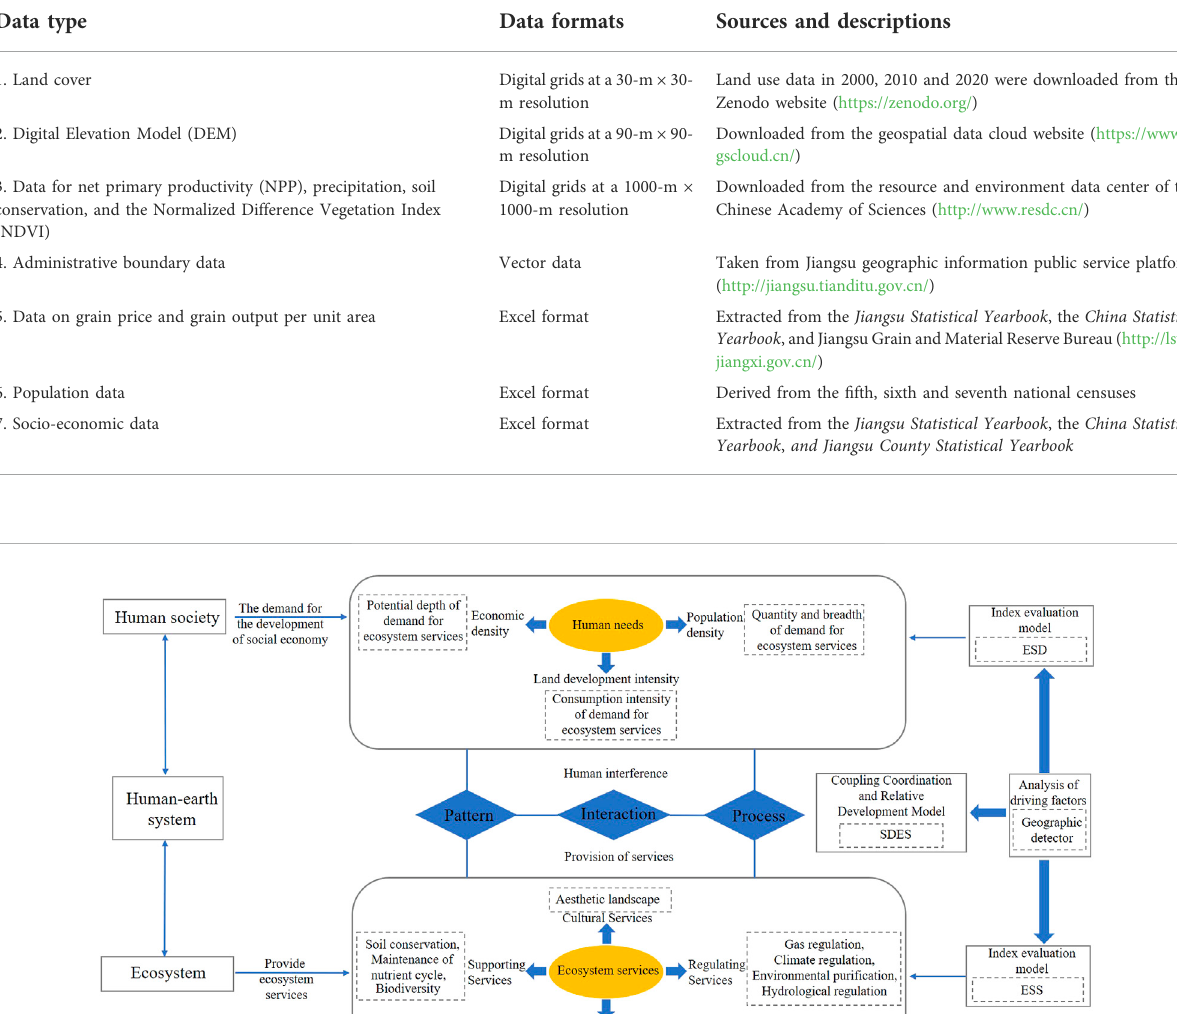
TABLE 1 The data requirements, sources, and descriptions.